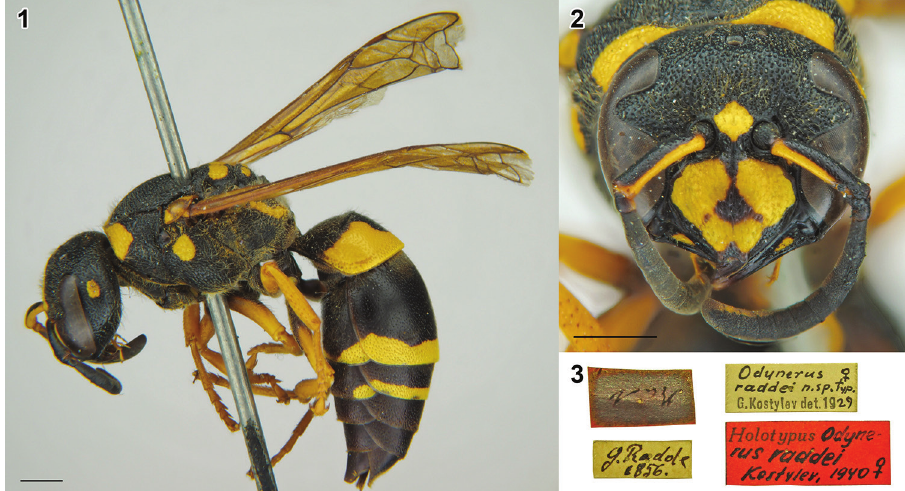
Figures 1–3. Odynerus ( Ancistrocerus ) raddei Kostylev, 1940, holotype, female (ZISP) 1 lateral habitus 2 head in frontal view 3 labels. Scale bars 1.0